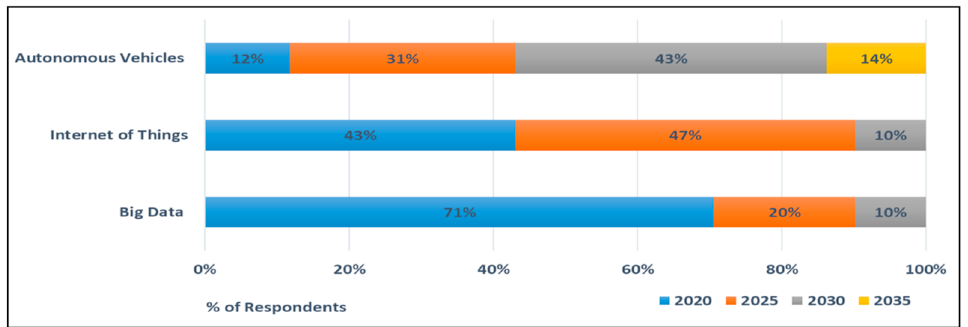
Figure 2. Innovative technologies expected maturity time line.